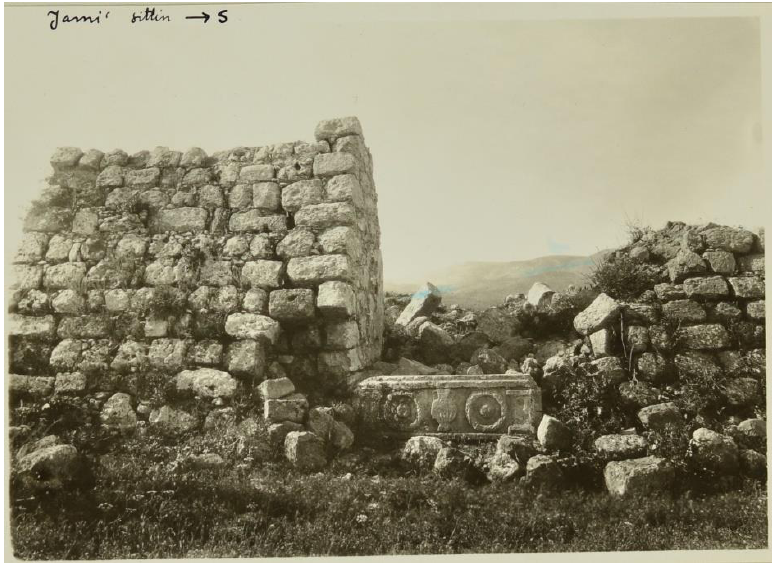
Figure 3. Jami ʿ al-Sitin and the polytheistic burial trough as lintel, from North. From the British Archive SRF_171 (http://www.iaa-archives.org.il/zoom/zoom.aspx?id=43097&folder_id=3380&loc_id=1025) (accessed on 27 September 2020).